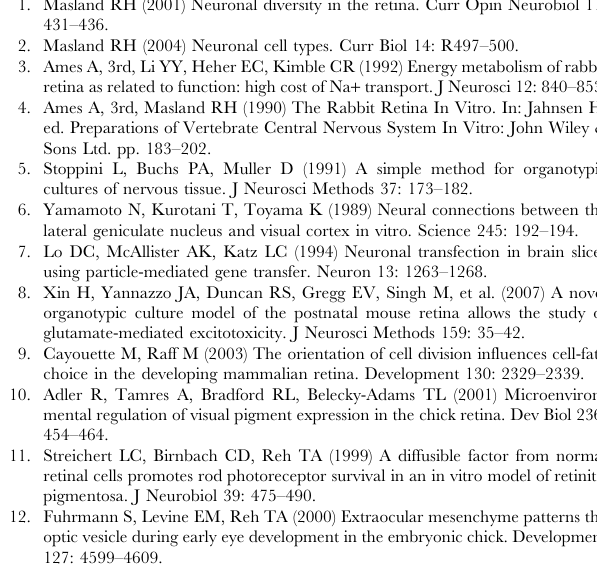
algorithm (Spike Sorter IV, Cyberkinetics) separated the wave- Figure S2 Directionally selective ganglion cell and starburst amacrine cell. Panel A, A directionally selective ganglion cell and an ON starburst cell (both in green) were found close to each other in a piece of transfected retina. The retina was counterstained with an antibody against ChAT (red) to reveal the starburst amacrine cells. DS ganglion cells are bistratified, the focus in panel A is on the OFF layer. Panel B, the same DS cell, focus on the ON layer. Scale bar for A & B, 50 m m. Panel C, vertical slice through a rabbit retina at high magnification. The dendrites of a DS ganglion cell are shown in green. The retina was counterstained with an antibody against ChAT (red). Note the two dendritic strata of the DS cell, both co-stratifying closely with the starburst amacrine cells’ dendrites. The cell body belongs to an ON starburst cell. Scale bar, 20 m m.